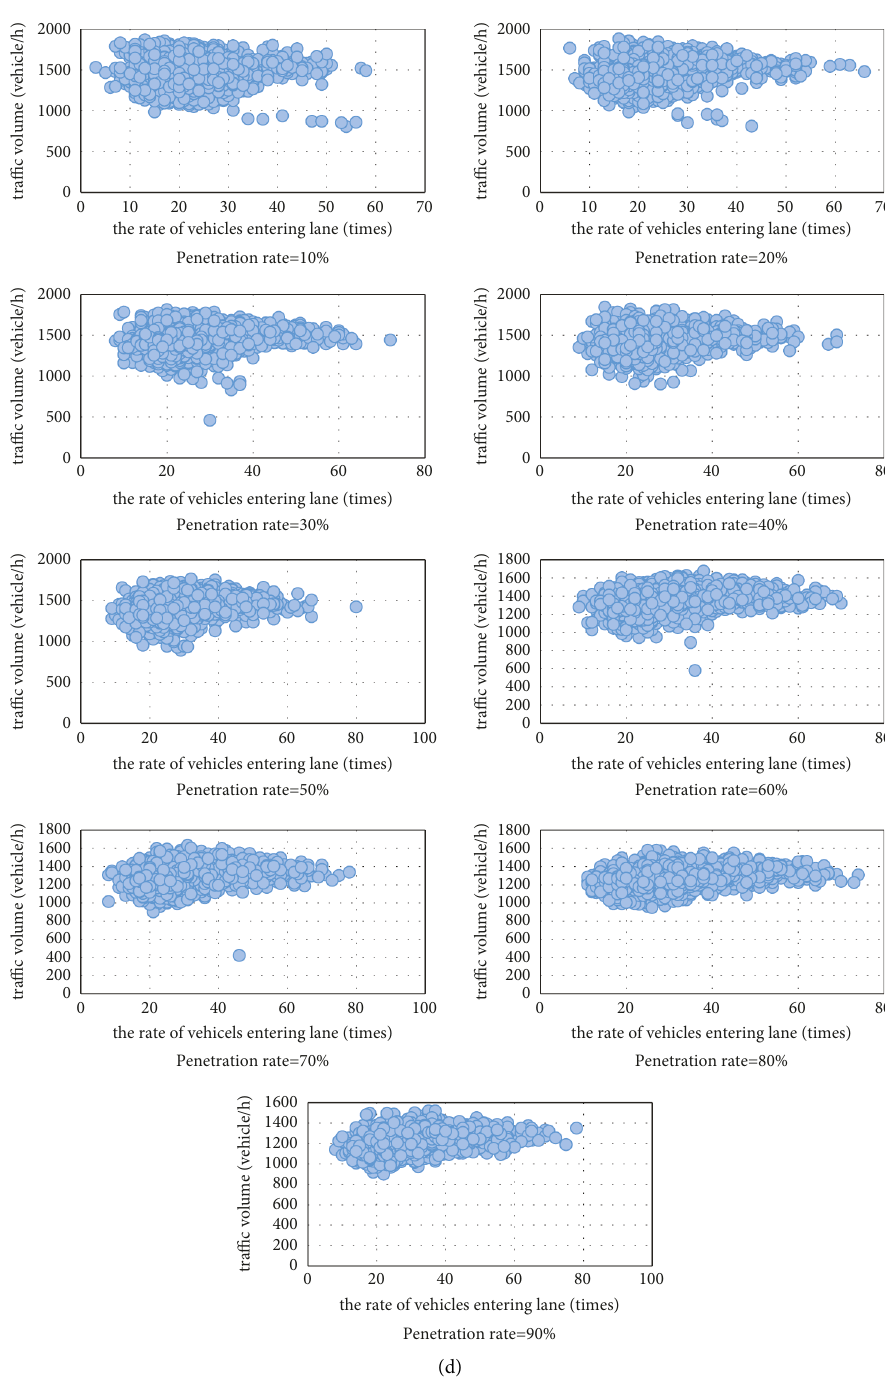
Figure 11: The relationship between the traffic volume and the rate of vehicles entering lane under different operating ratios of autonomous driving vehicles in different lanes. (a) Relationship diagram of Lane 1. (b) Relationship diagram of lane 2. (c) Relationship diagram of lane 3. (d) Relationship diagram of lane